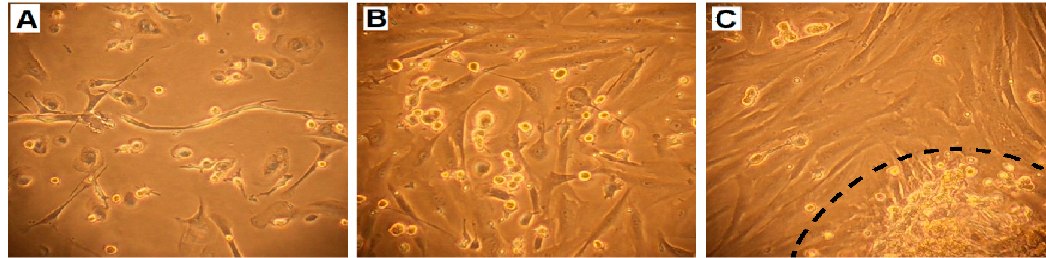
Figure 3. Initially, cell culture from ascitic fluid was heterogeneous and consisted of cancer cells, fibroblasts, and mesothelial cells ( A – B ). In higher confluency cancer cells tended to grow as spheres ( C —inside the dotted line) on the layer of non-cancerous cells (Axiovert 40 CFL Inverted Phase Contrast Microscope, Zeiss , Oberkochen, Germany; magnification: 100×).